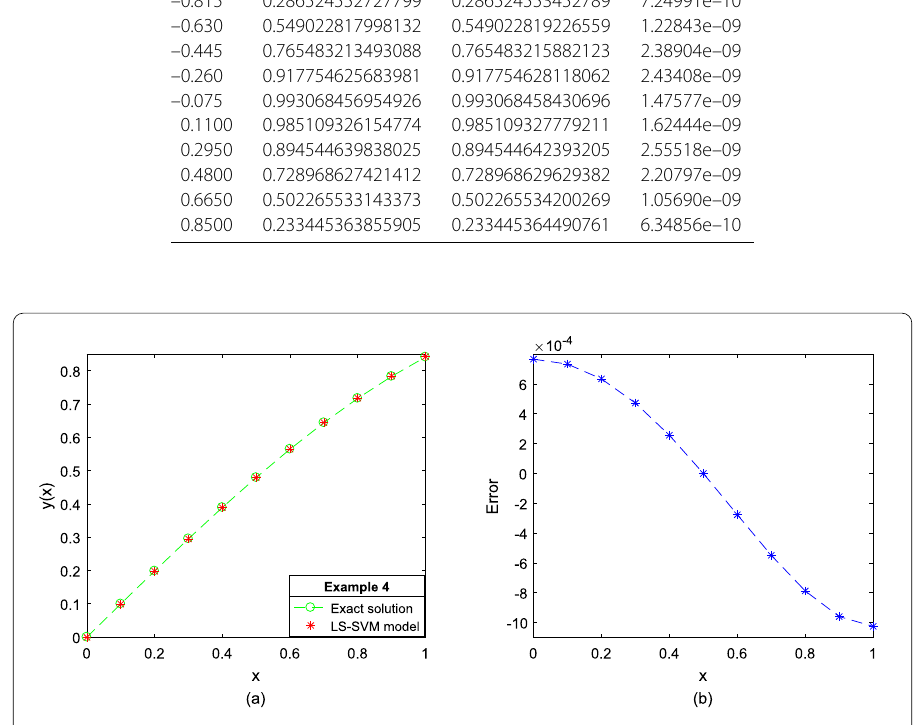
Figure 5 Multi-point BVP of third-order nonlinear ODE (Example 4)